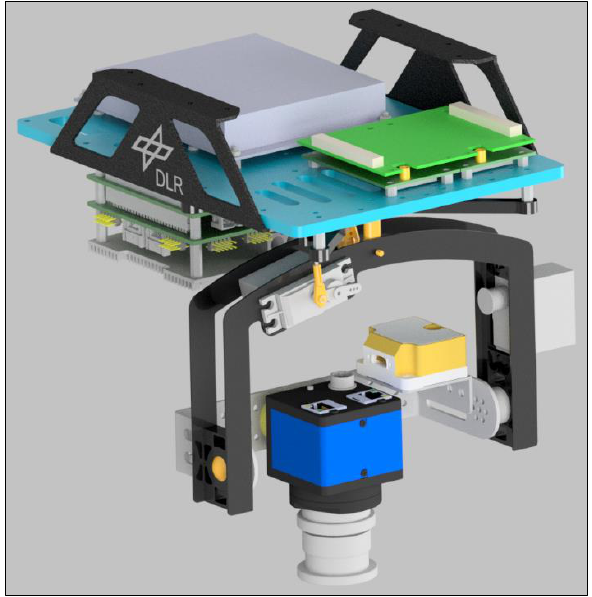
Figure 2: CAD model of current aerial camera system without wiring and dual frequency GNSS antenna